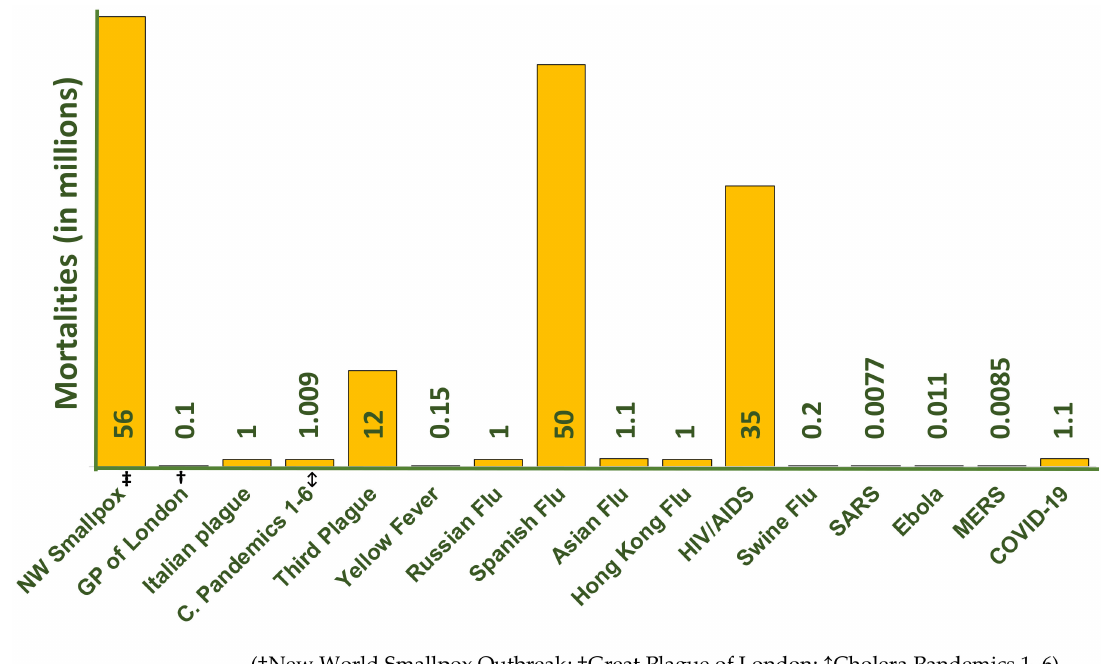
Figure 2. World pandemic